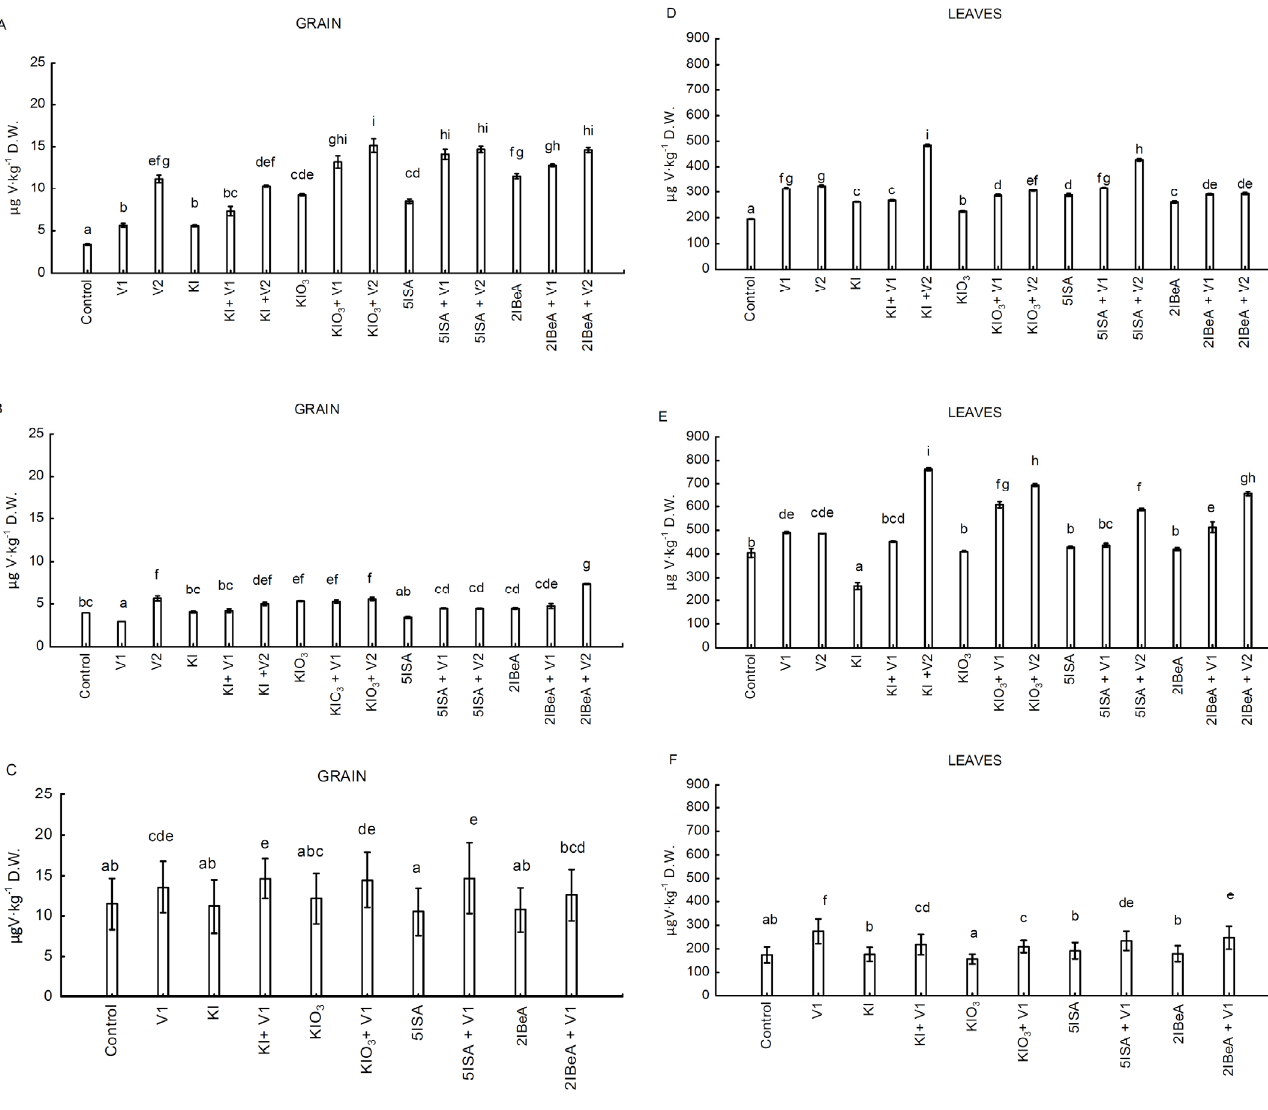
Figure 3. Vanadium contents in grain in experiment No.1 ( A ), No.2 ( B ) and No.3 ( C ) and in leaves in Experiment No.1 ( D ), No.2 ( E ) and No.3 ( F ) of sweetcorn plants. Means followed by different letters for treatments differ significantly at p < 0.05 ( n = 8). Bars indicate standard error.